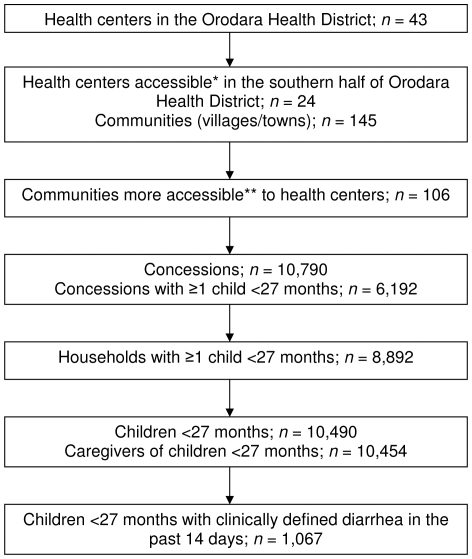
Summary of sampling framework for the survey in rural southwestern Burkina Faso.The sampling framework for the participation of health centers, communities, concessions, households, and children in the survey. Health centers and communities were first selected based on their accessibility by vehicle. In each community, concessions and households were visited to identify children <27 months of age and to interview their primary caregivers.